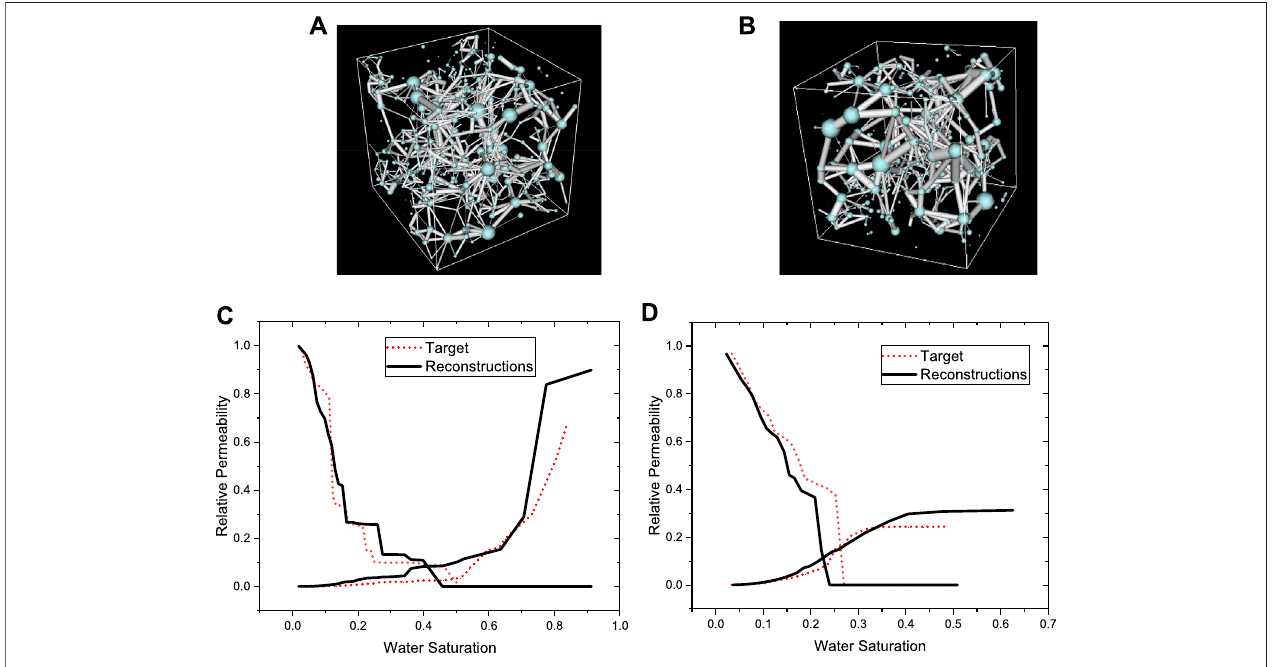
FIGURE 9 | Pore network model and seepage experiment of the reconstructed structure and the target sample. (A) Pore network model of micro-CT image; (B) Pore network model of 3D reconstructed image; (C) oil fl ooding process; (D) water fl ooding process.